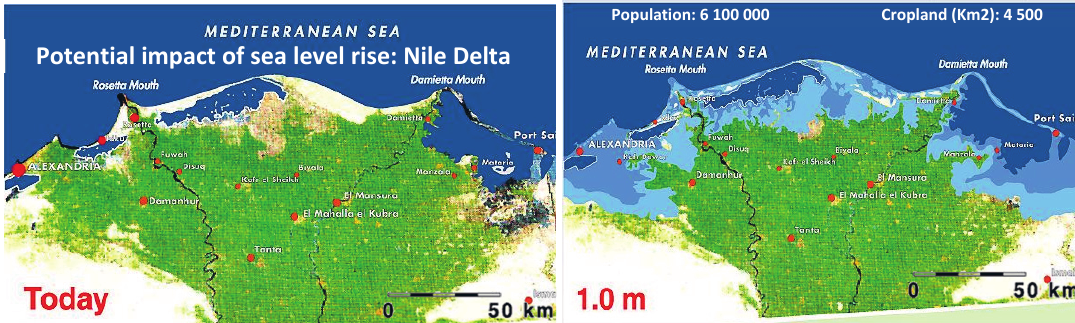
Figure 5. Maps of the Nile Delta showing potential impacts of a 1 m rise in sea level (Maps from open